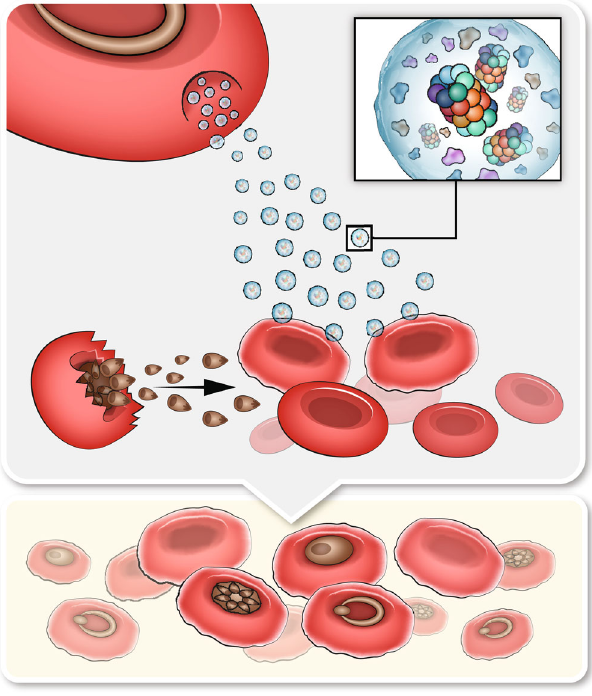
Fig. 6 Pf -derived EVs prime naïve host RBCs to enhance parasite growth. Diagram demonstrating the impact of Pf -derived EVs on naïve RBCs.